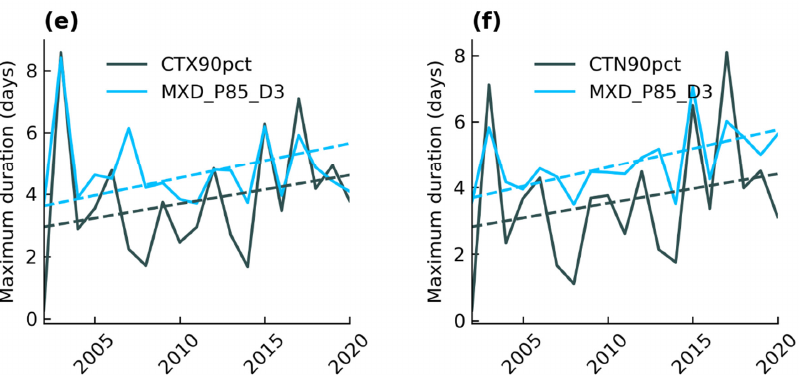
Figure 3. Timeseries of HWN ( a , b ), HWF ( c , d ), and HWD ( e , f ) for summer heatwaves (CTX90pct and CTN90pct) and LST anomalies (MXD_P85_D3) in the Mediterranean region (2002–2020); dashed lines represent trends.